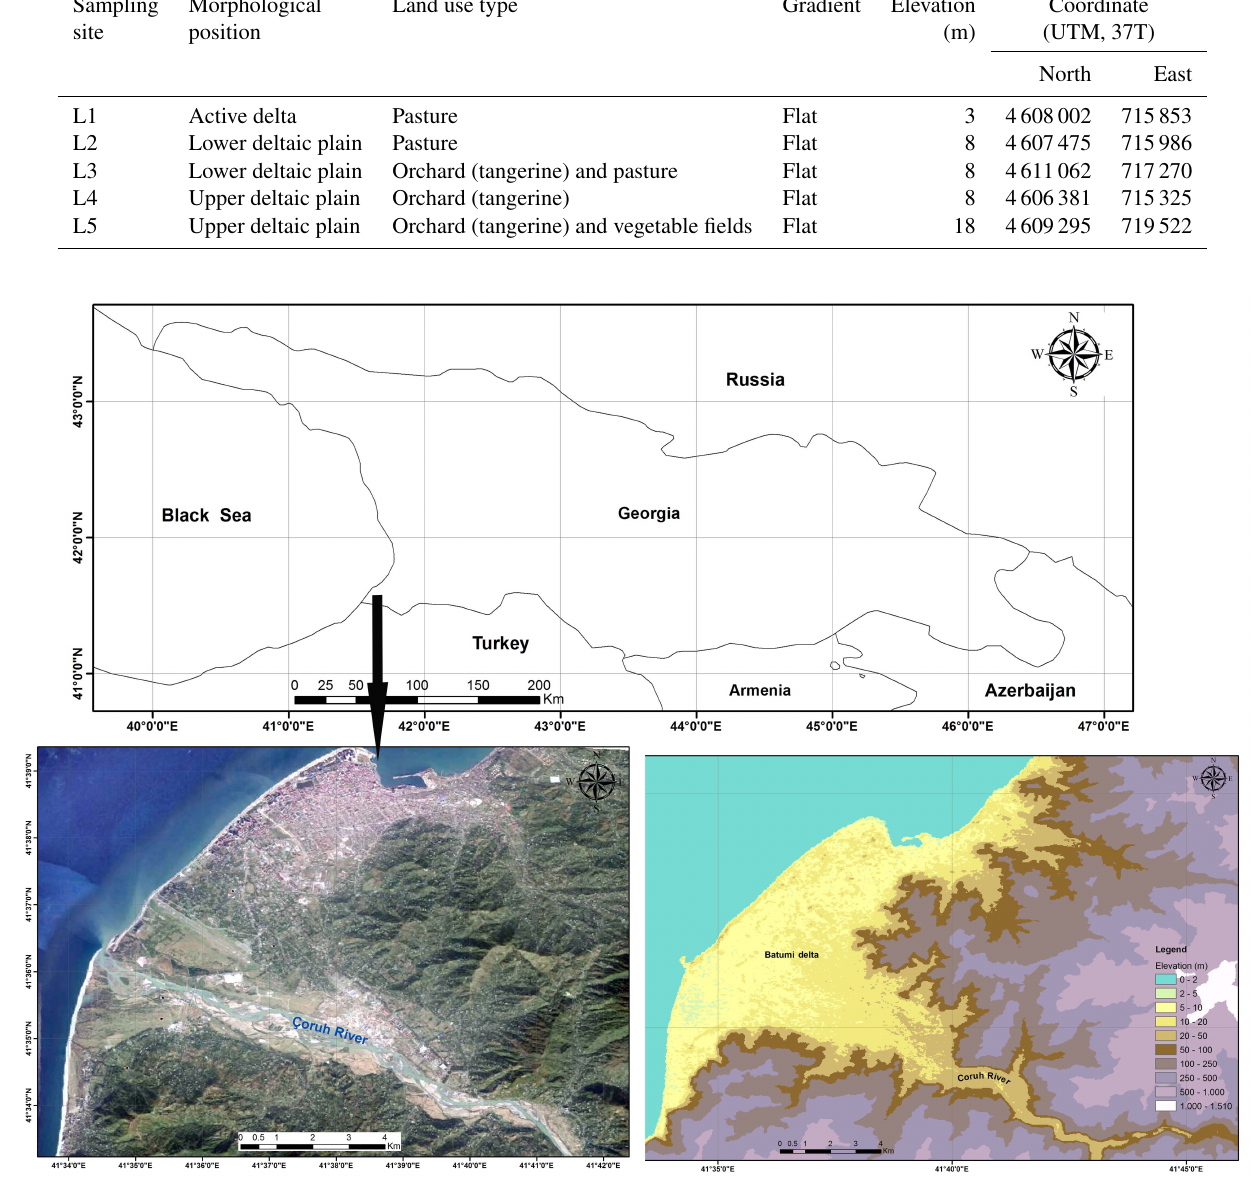
Figure 1. Location of the Batumi delta and digital elevation model (DEM) of study area.